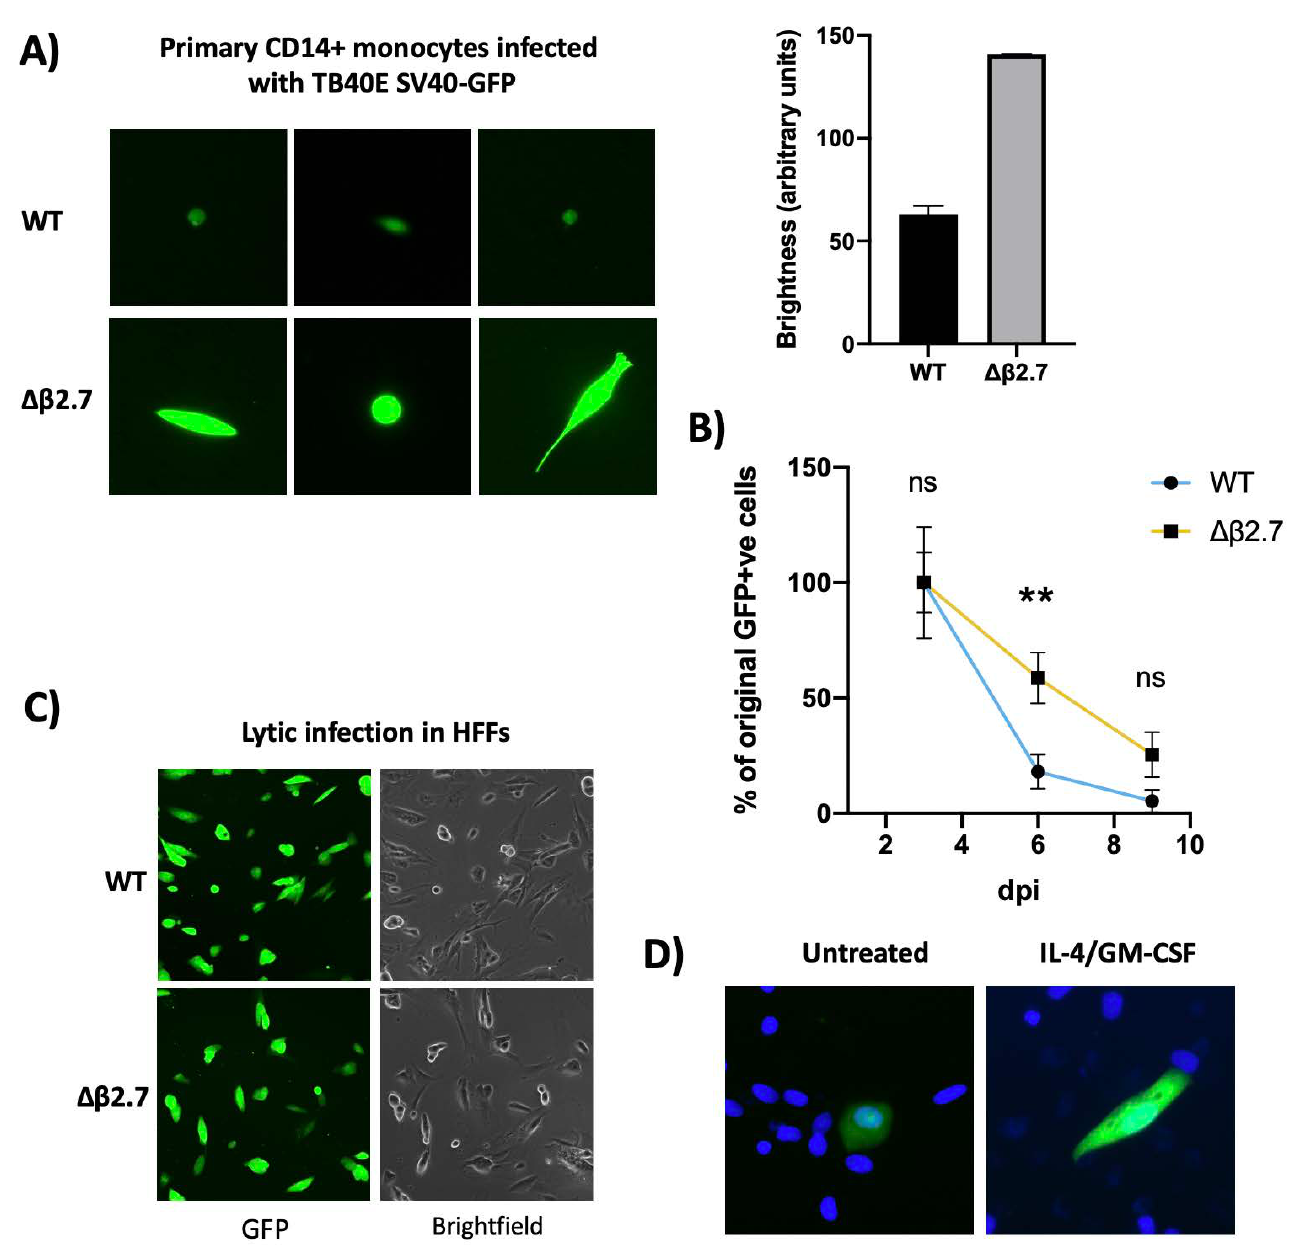
Figure 1. ∆ β 2.7 virus differs in both intensity and duration of GFP expression in CD14+ cells. ( A , B ) Primary CD14+ monocytes were infected with WT SV40-GFP TB40E (WT) or ∆ β 2.7 SV40-GFP TB40E ( ∆ β 2.7) virus at an MOI of 5. ( A ) Images were captured at 7 d.p.i using a 20 × lens and quantified on the right using densitometry analysis from ImageJ software. ( B ) The number of GFP-positive cells in each condition were also counted at 3, 6 and 9 d.p.i and the mean and standard deviation from experiments, performed in triplicate, were plotted. The absolute number of GFP-positive cells at 3 d.p.i was 275.9 ± 86.7 for WT infection and 309.8 ± 87.9 for ∆ β 2.7 infection. Significant difference was calculated using a 2-way ANOVA with Sidak’s post hoc testing. ** = p < 0.01. ns = not significant. ( C ) Human foreskin fibroblasts were infected with WT or ∆ β 2.7 virus at an MOI of 0.5 and imaged at 3 d.p.i on a 10 × lens. ( D ) CD14+ monocytes were infected with WT virus. Half of these cells were differentiated and matured with IL-4/GM-CSF + LPS. Images were taken at 7 d.p.i using the 20 × lens on a fluorescence